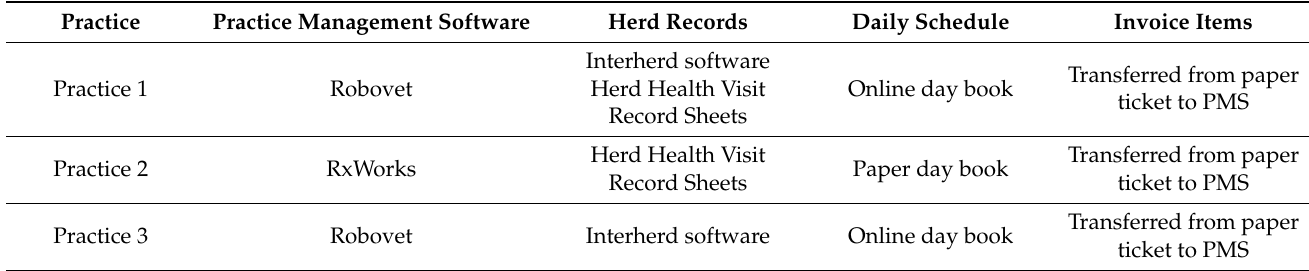
Table 2. Sources of information identified for possible retrospective data collection within the 3 practices undertaking a farm animal related clinical